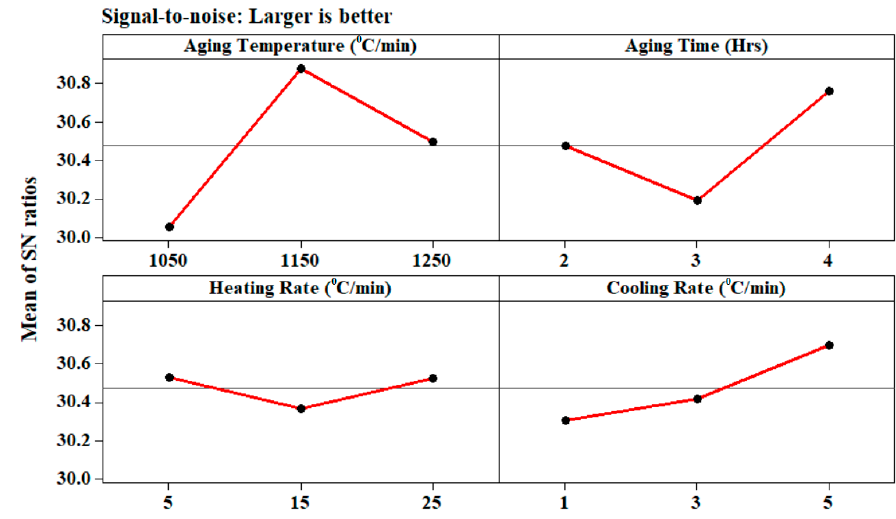
Figure 15. Main effects plot for thermal conductivity. The second-order model representing the thermal conductivity can be expressed as a “function of processing parameters”(Equation (13)) such as aging temperature ( ◦ C), aging time (hours), heating rate ( ◦ C/min), and cooling rate ( ◦ C/min) as shown in Equation (8) using the estimated regression coefficients (Table 12).